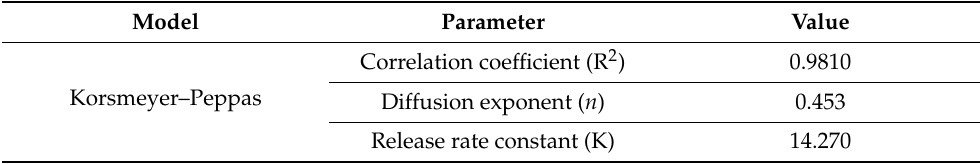
Table 3. DSP release kinetics from AG-1 using Korsmeyer–Peppas model.